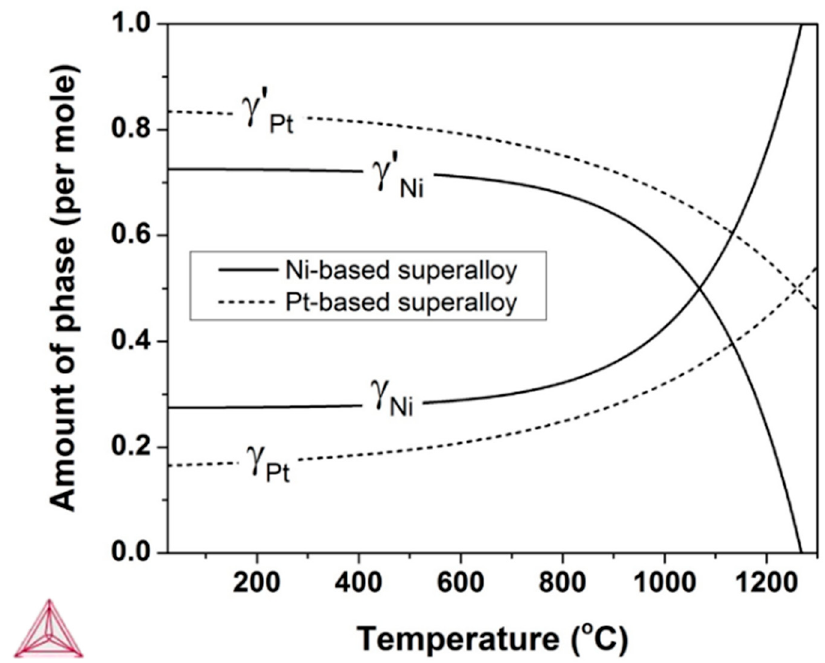
Figure 10. Phase compositions of Ni-based and Pt-based superalloy as a function of temperature.